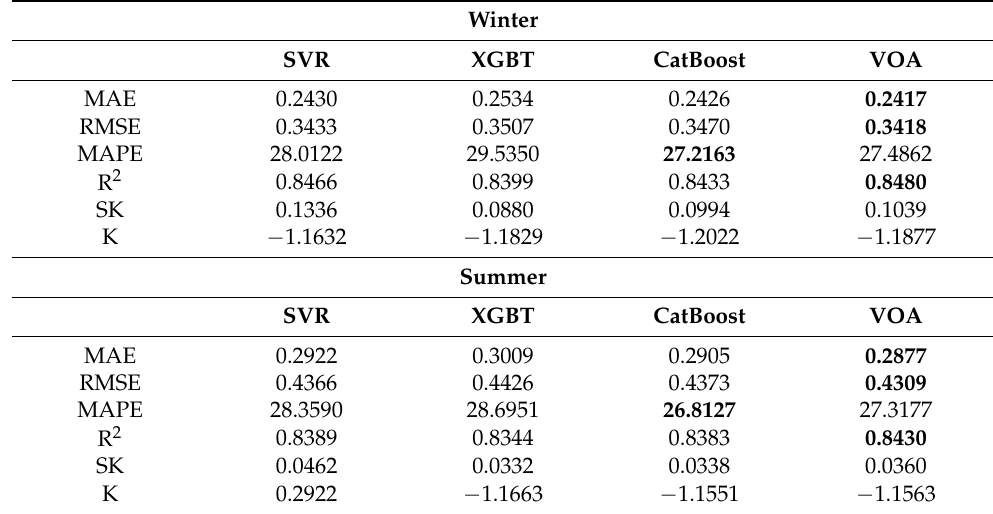
Table 6. Forecasting accuracy of ML algorithms (1 h ahead).